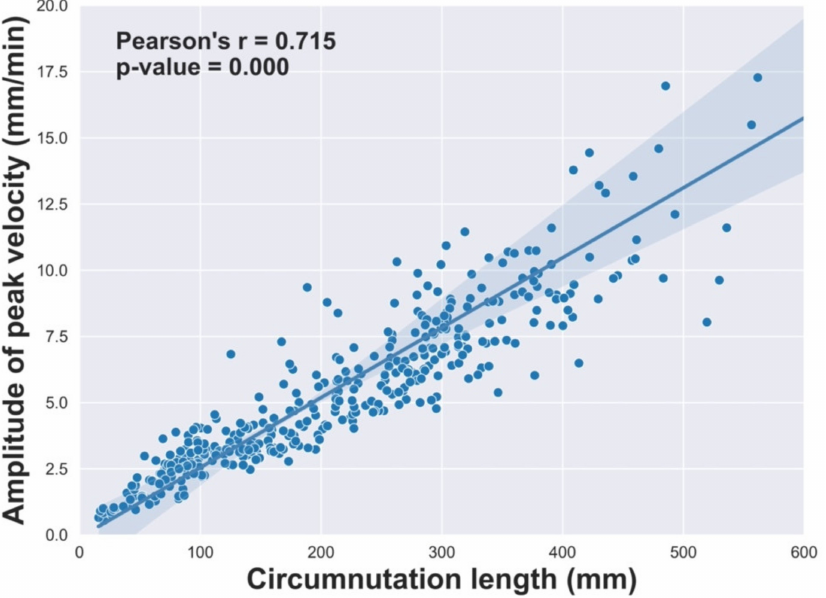
Figure 2. Pearson’s correlation coefficient between the “circumnutation length” and the “amplitude of peak